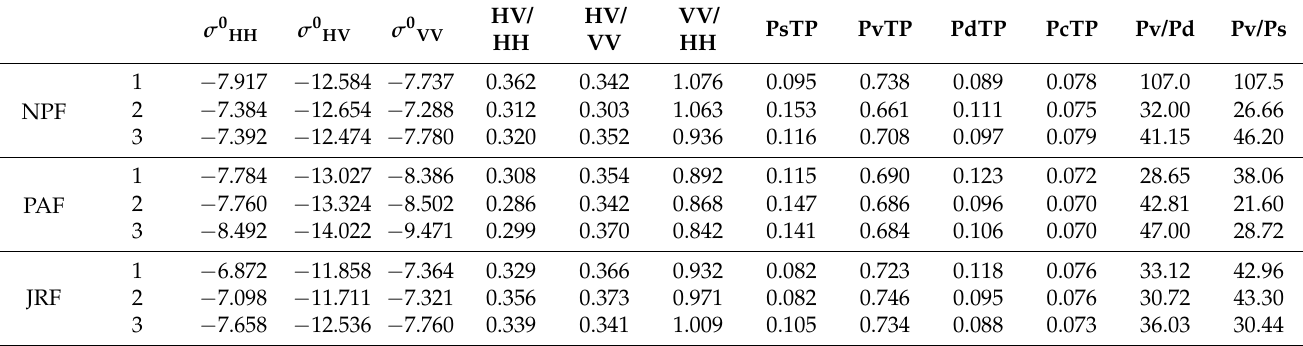
Table 3. SAR polarimetric parameters for each survey transect. Digital Number (DN) values within a 50 m radius buffer around each survey transect were